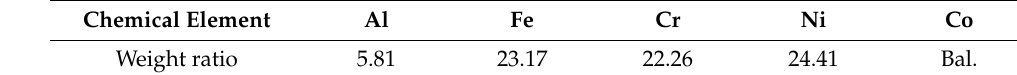
Table 1. Chemical composition of 316 stainless steel (wt.%). Chemical Element Si Mn wt.% Table 2. Chemical composition of Al 0.5 FeCoCrNi (wt.%).